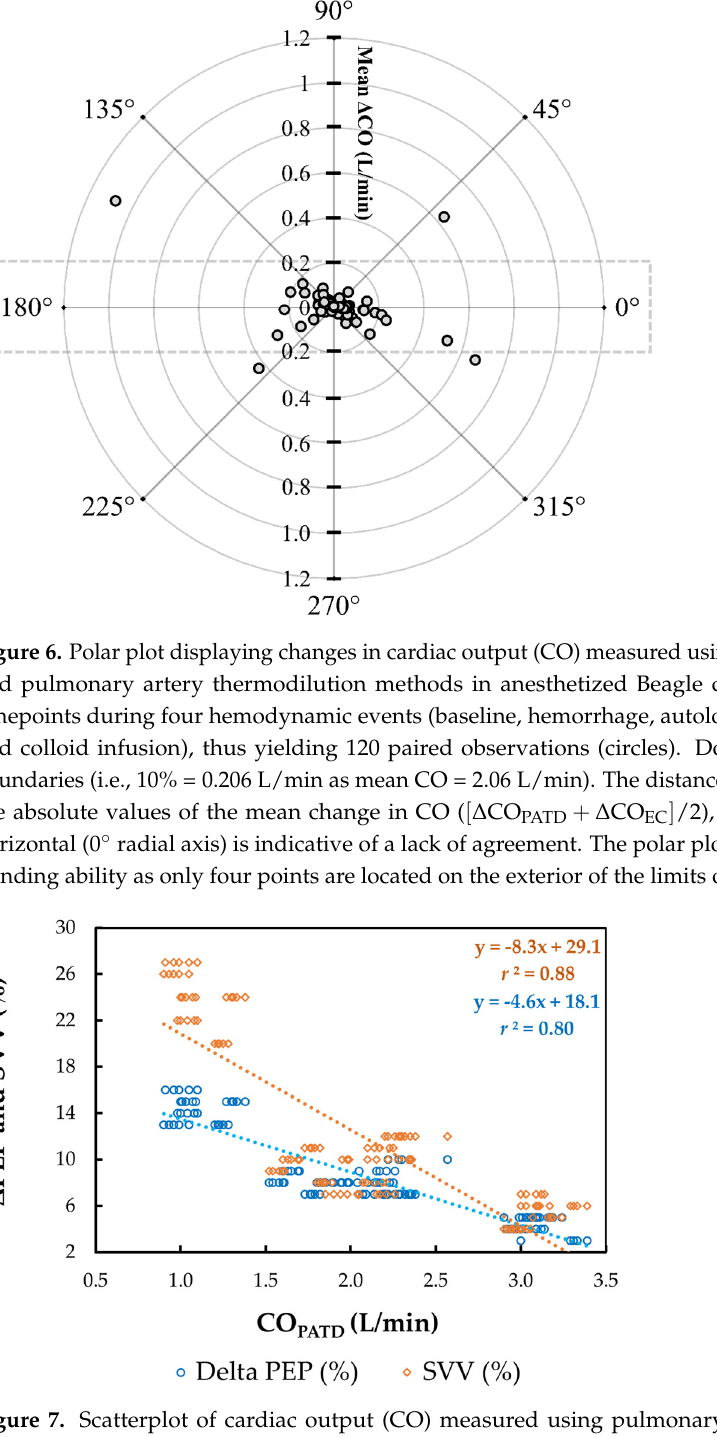
measured using electrical cardiometry (CO EC ) and pulmonary artery thermodilution (CO PATD ) tech-